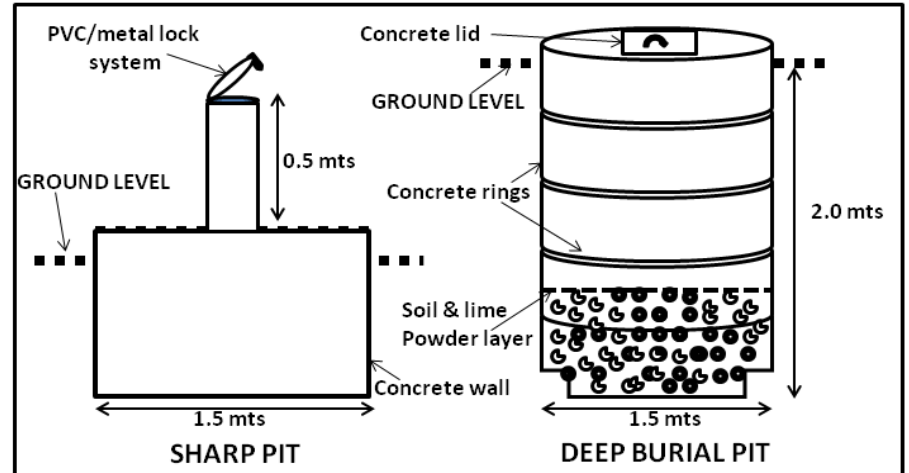
Figure 3. Schematic diagrams of sharp pit and deep burial pit used for disposal of solid healthcare